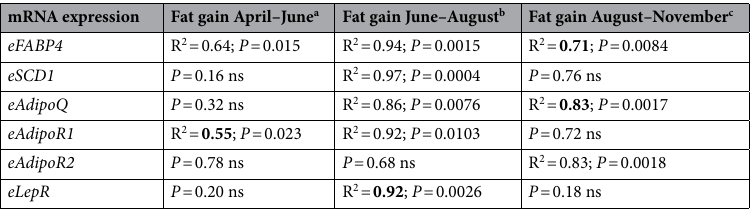
Table 7. Regression of fat gain on gene expression. eFABP4: emu Fatty Acid Binding Protein ; eSCD1: emu Stearoyl-CoA desaturase-1 ; eAdipoQ: emu Adiponectin ; eAdipoR1: emu Adiponectin Receptor1 ; eAdipoR2: emu Adiponectin Receptor2 ; eLepR: emu Leptin Receptor. Bold R 2 values indicate negative regression. a Fat gain regressed on April mRNA expression. b Fat gain regressed on June mRNA expression. c Fat gain regressed on August mRNA expression.